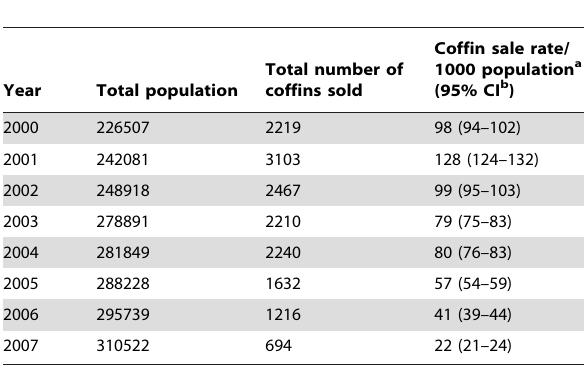
Table 3. Coffin sales (2000–2007) at coffin workshops in 5 traditional authorities in Thyolo district,